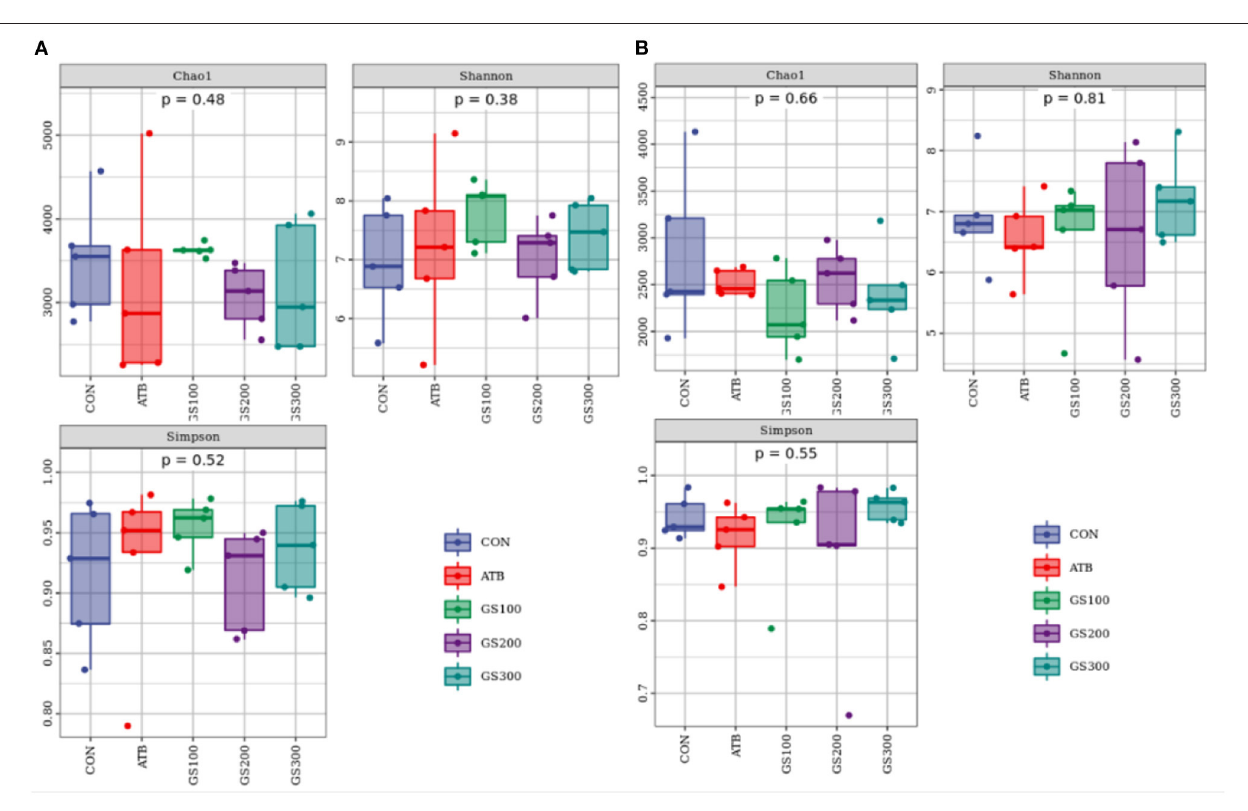
dietary Rg1 supplementation had little effect on the intestinal microbiota